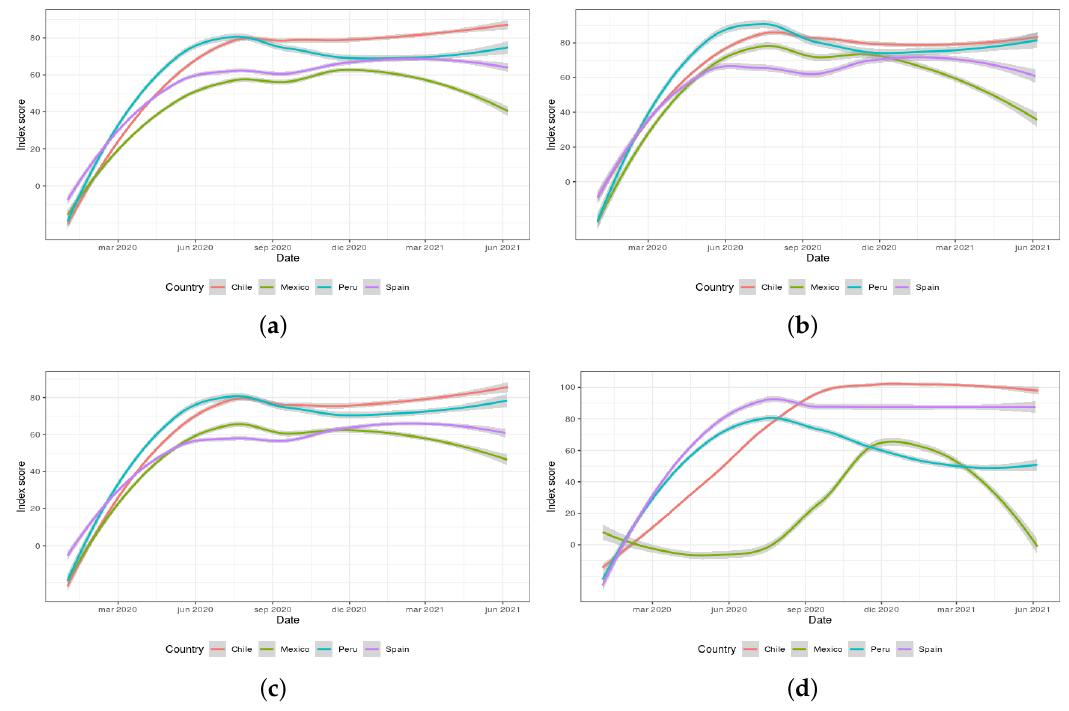
Figure 7. OxCGRT dataset global indexes for Chile, Mexico, Peru, and Spain: ( a ) overall government response index; ( b ) stringency index; ( c ) containment and health index; and ( d ) economic support